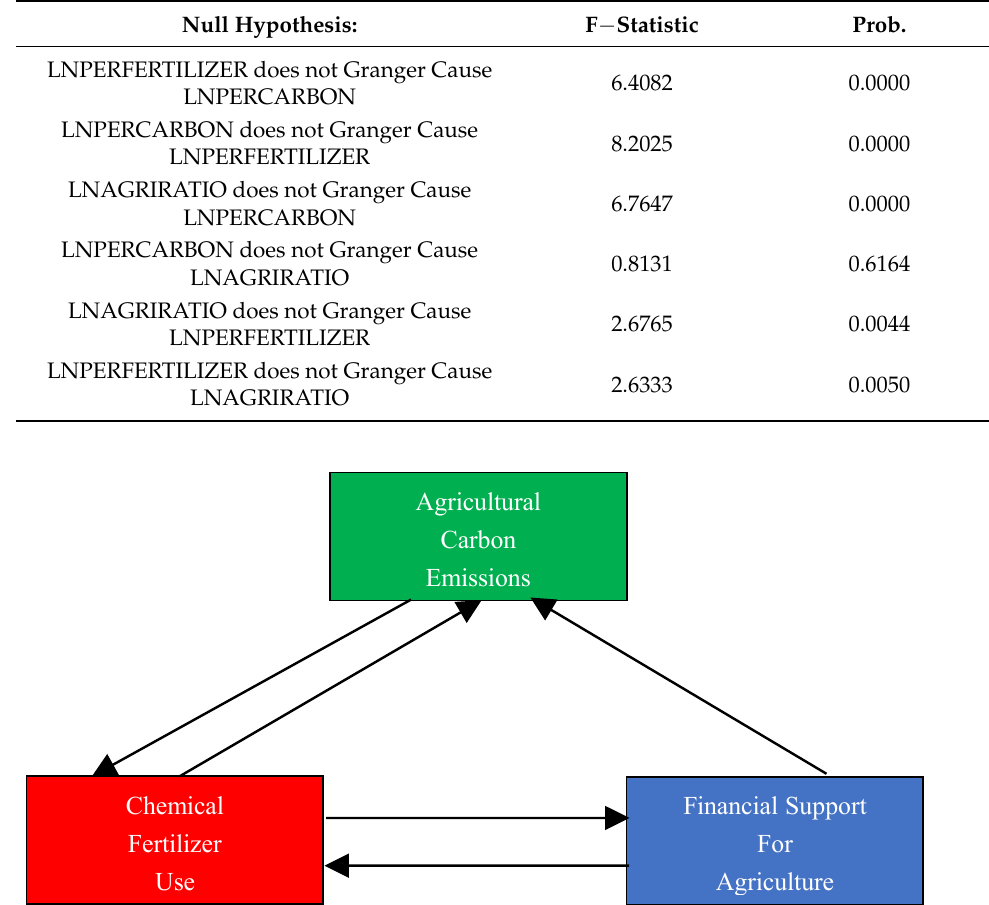
Table 8. Pairwise Granger causality tests.